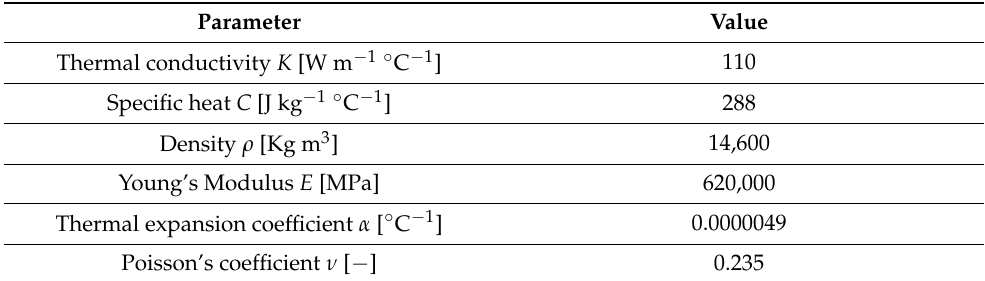
Table 3. Thermophysical properties of the cutting tool workmaterial.